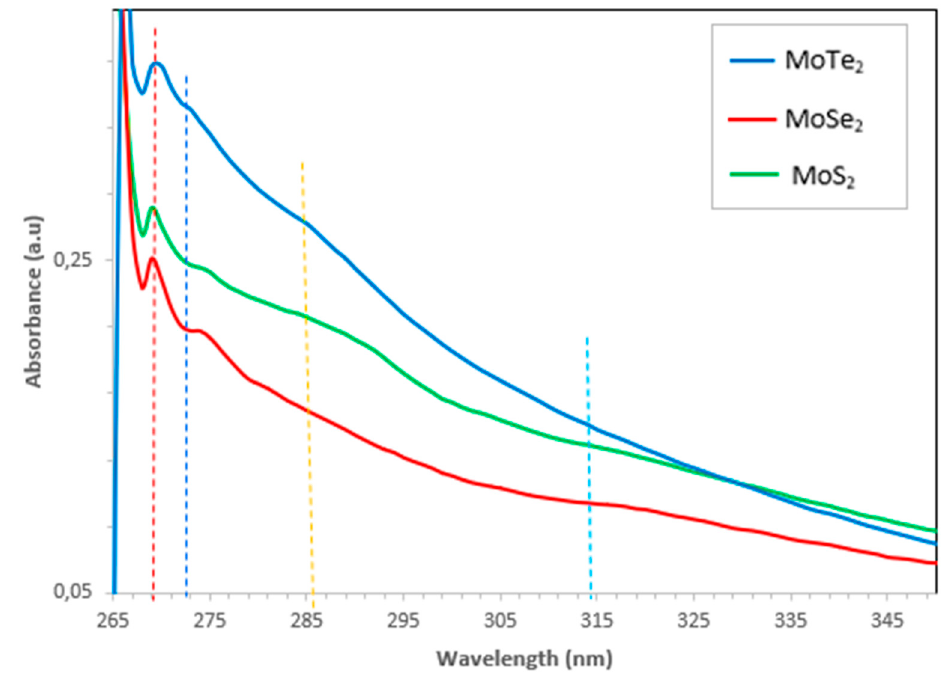
Figure 5. UV–Vis spectra of the MoX 2 (X = S, Se, Te) nanoparticles.